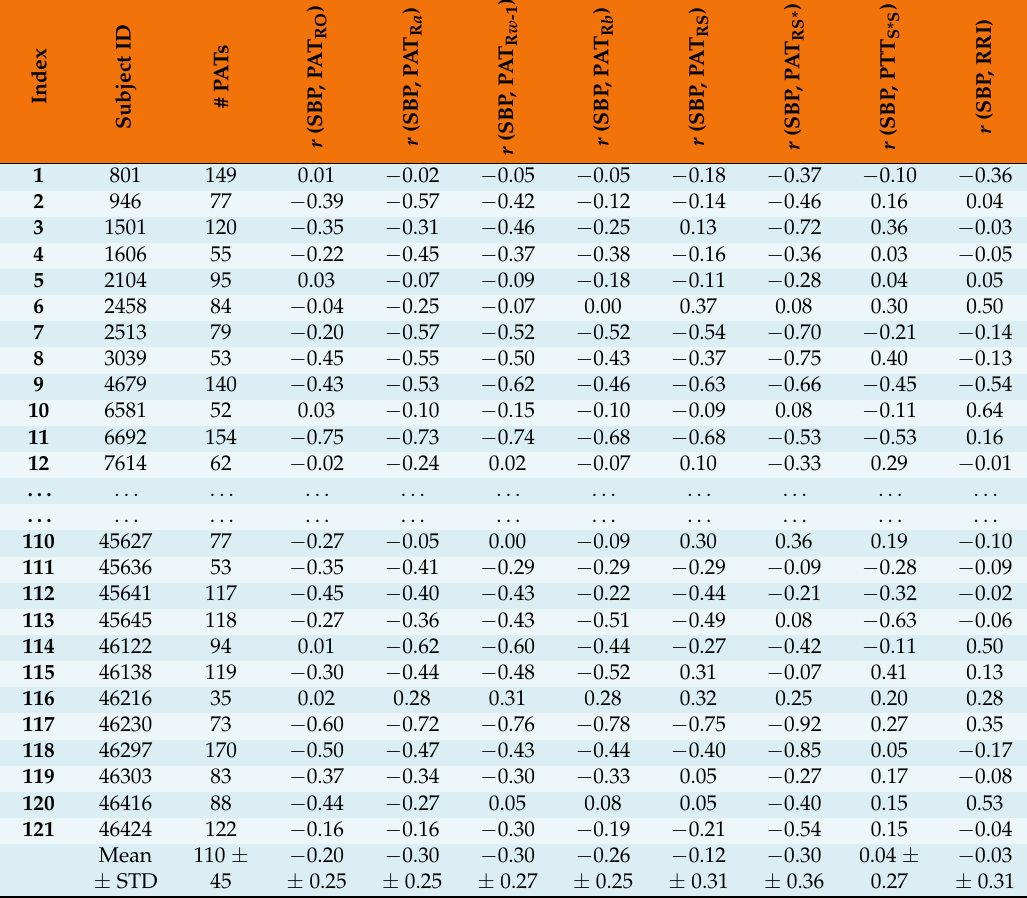
Table 3. The Pearson correlation coefficient for each subject between blood pressure and arterial wave propagation features. Note: The “subject ID” is the same as in the MIMIC database. “#PATs” means the quantity of extracted beat records from each subject. Note, SBP refers to systolic blood pressure, PAT refers to pulse arrival time, PTT refers to pulse transient time, RRI refers to R-R interval extracted from ECG signal, STD refers to standard deviation, and r refers to Pearson’s correlation coefficient.